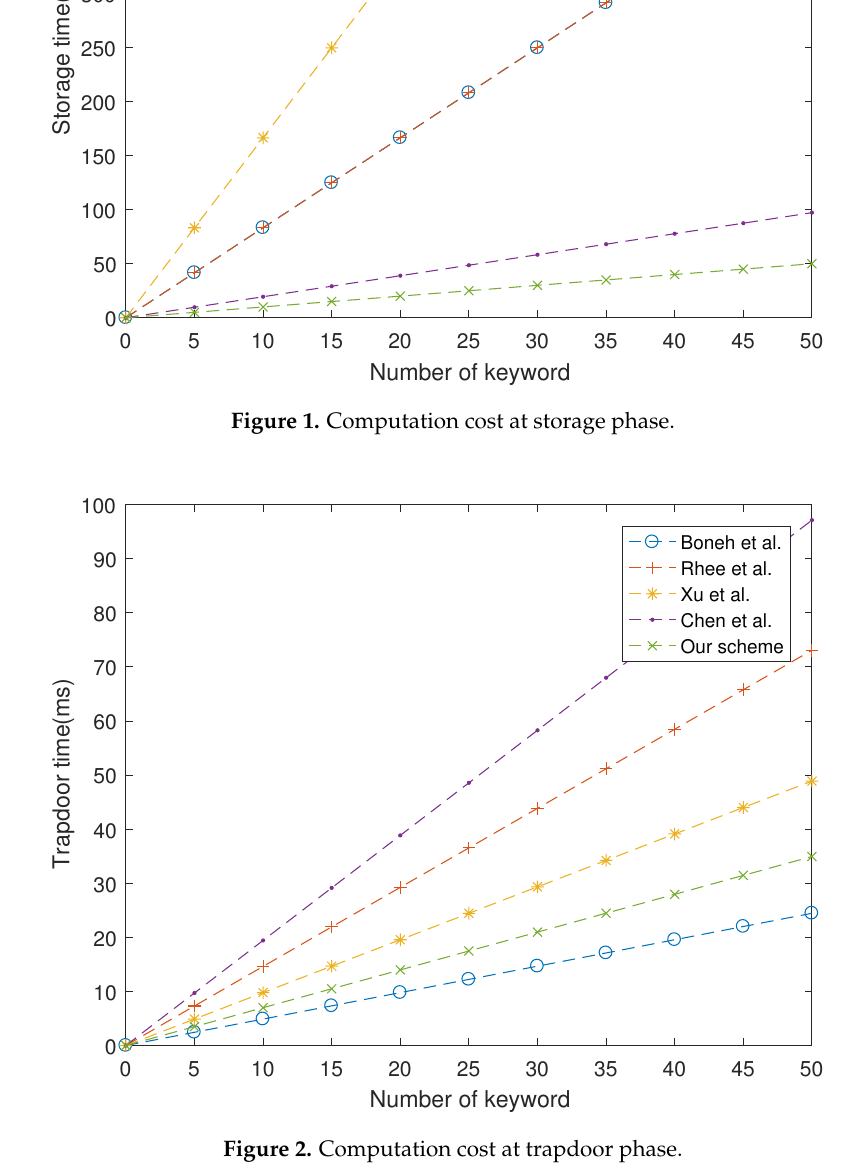
Figure 2. Computation cost at trapdoor